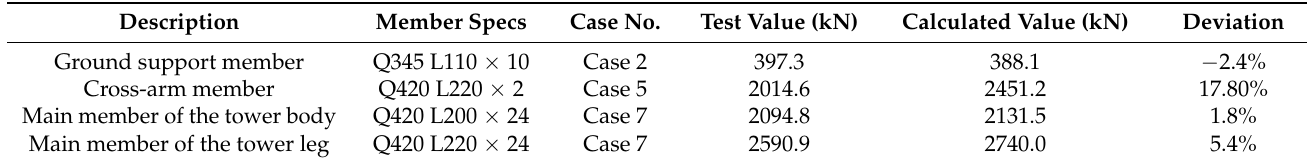
Table 7. Comparison of the axial force of tower members with 100%